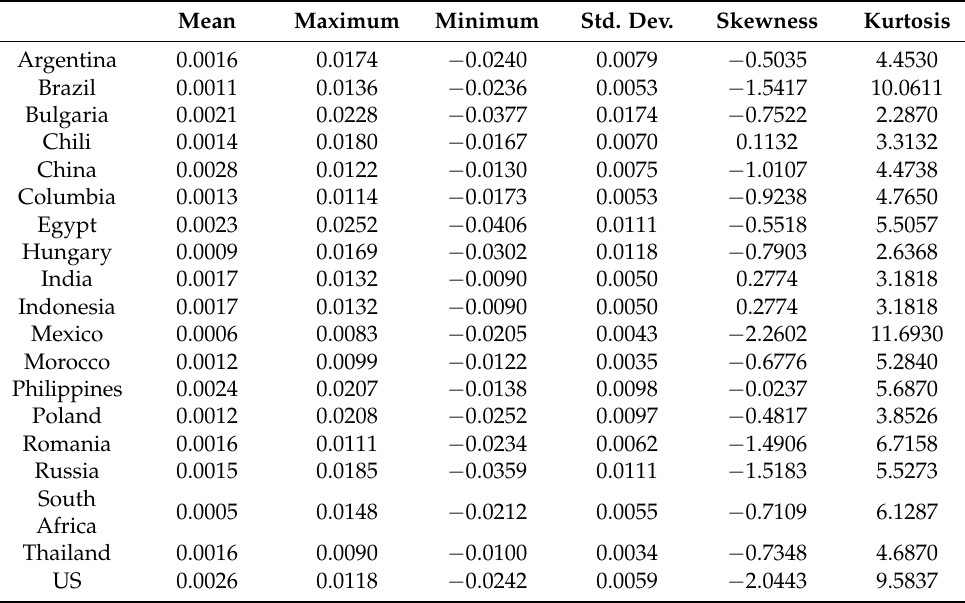
Table 2. Descriptive statistics for the real GDP